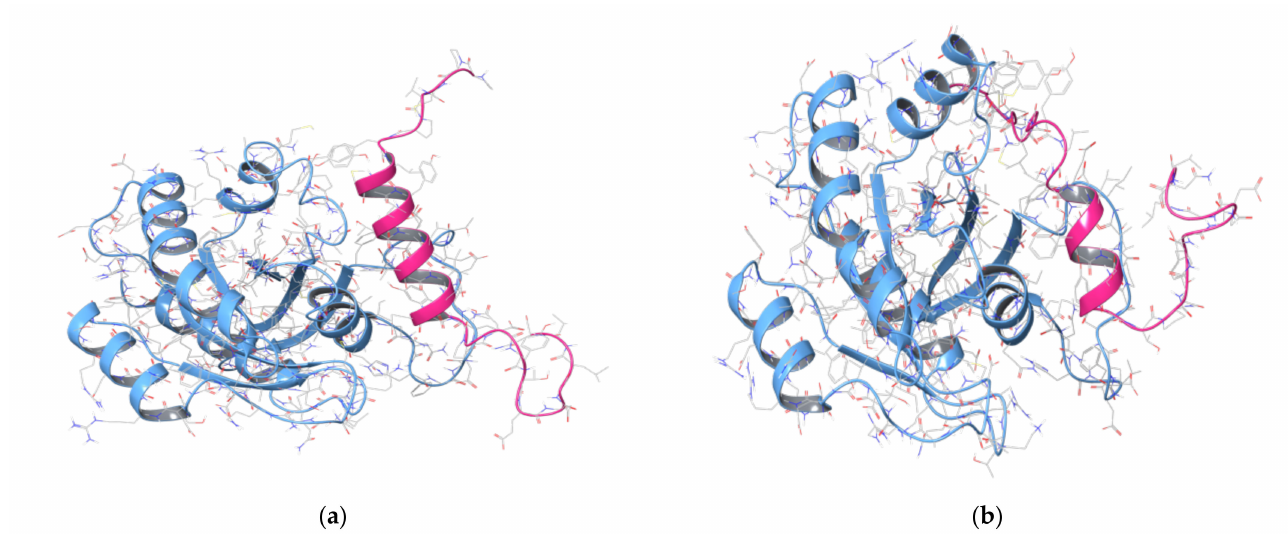
Figure 5. ( a ) Frame 0 of the first MD simulation on Ras (blue chain) in complex with a RasGRF1 fragment (pink chain, aa 1173 to 1203); ( b ) frame from the first MD simulation on Ras in complex with a RasGRF1 fragment after about 50 ns, depicting the RB3 peptide losing helicity propensity in the portion from Met1181 to Thr1184.